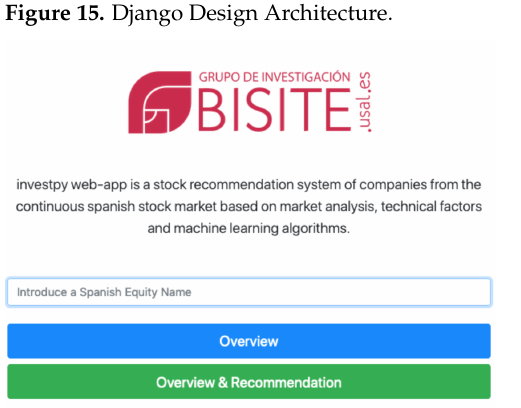
Figure 15. Django Design Architecture.